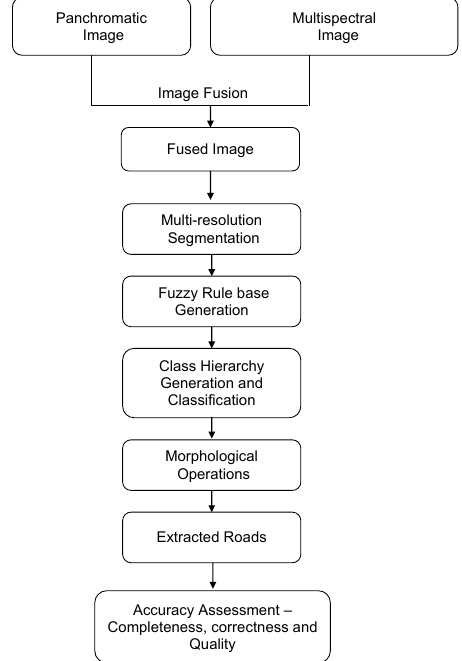
Figure 1 : Integrated Work Flow